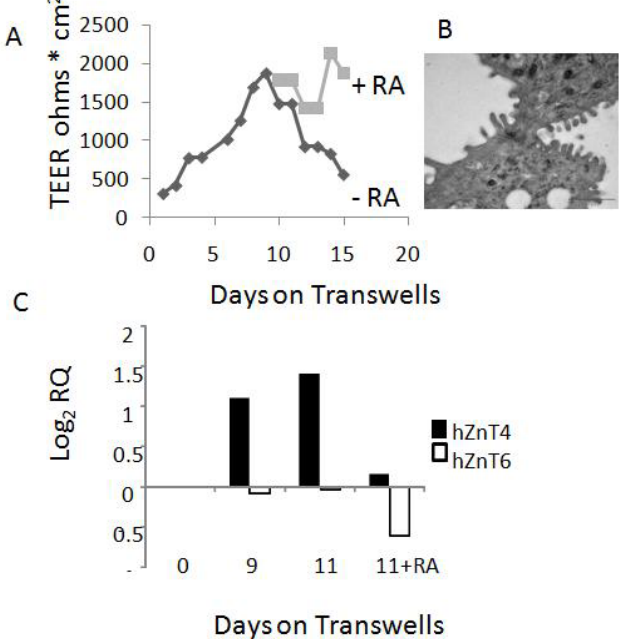
Figure 2. ZnT4 in air-liquid interface cultures of normal human bronchial/tracheal epithelial cells (NHBE). ( A ) Changes in transepithelial resistance (Trans-Epithelial Electrical Resistance (TEER), ohms × cm 2 ) plotted against days in culture on transwell filters (see methods). Note the steep increase in TEER up to day 9 of culture and loss of TEER after day 9 in the absence, but not presence, of retinoic acid (RA); ( B ) Transmission electron micrograph showing a typical tight junction formed in cultures exposed to RA; ( C ) ZnT4 mRNA relative to hypoxanthine phosphoribosyltransferase (HPRT) increased during culture on filters but was lost following addition of RA. For comparison, ZnT6 did not increase during